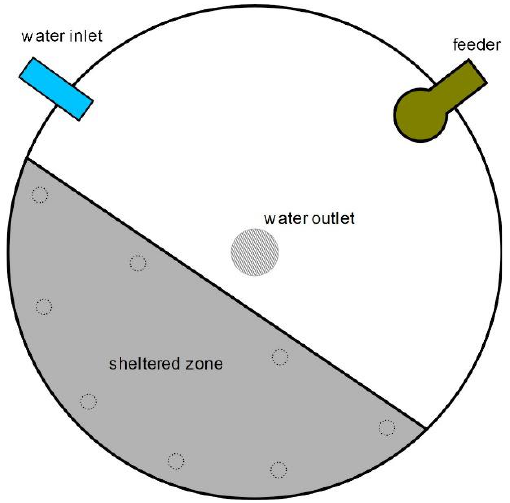
Figure 1. Scheme showing the positioning of the immersed covers in the sheltered tanks. Dash-line circles indicate the position of the legs of the shelter.